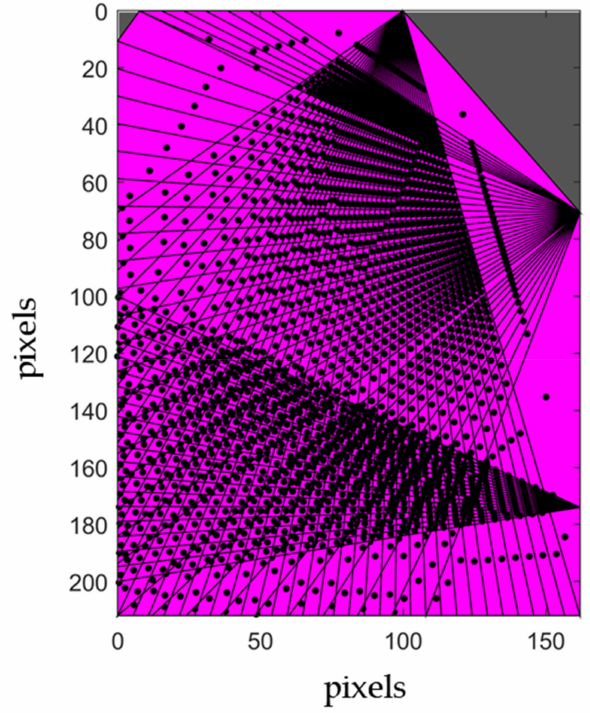
Figure 3. Tessellation of the investigated area of 162 × 212 pixels. The points correspond to the barycenters of the tiles.